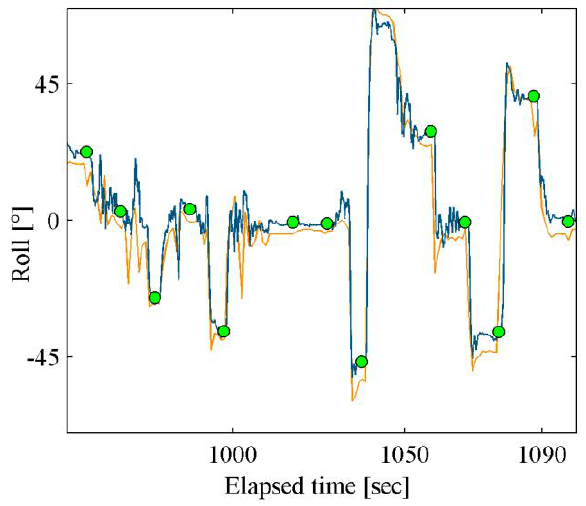
Figure 5. Detailed view on the roll angles (orange: Solmeta Geotagger Pro 2; blue: APM 2.0; green dot: